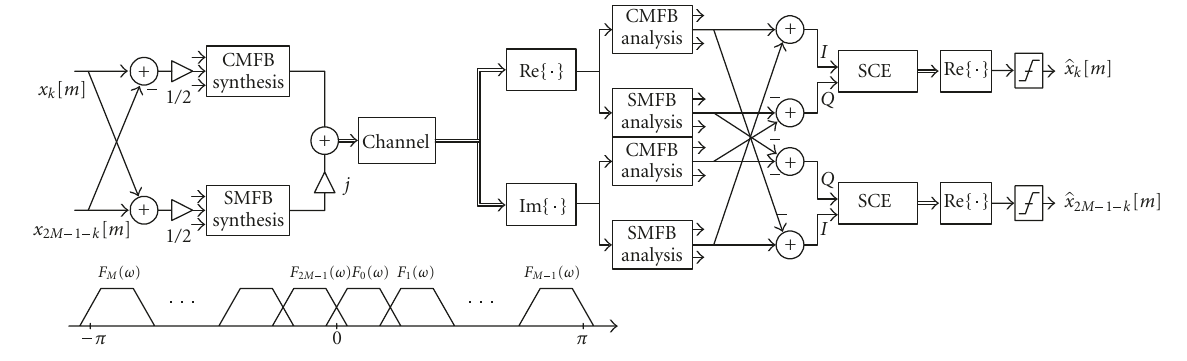
Figure 1: Complex TMUX with oversampled analysis bank and per-subcarrier